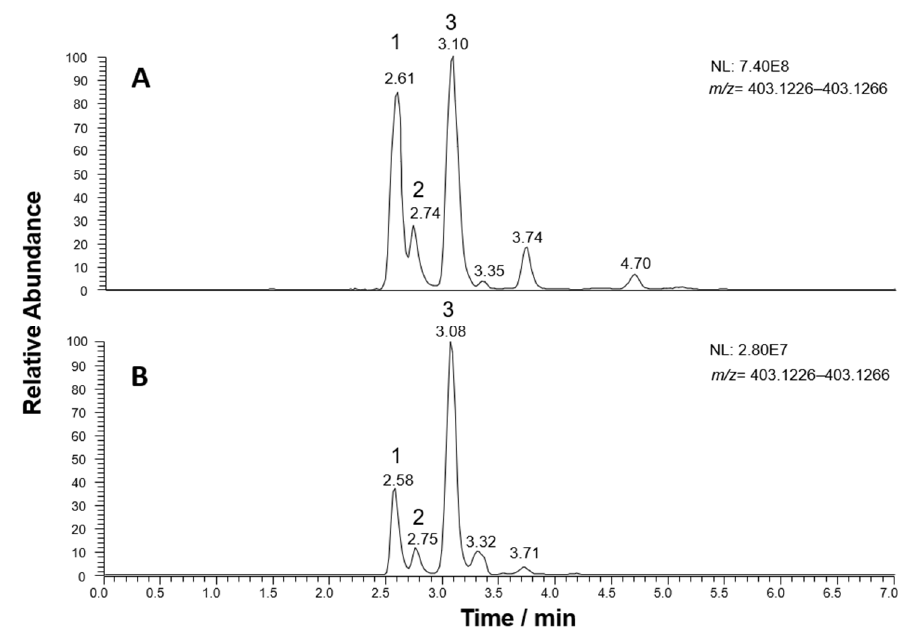
Figure 5. Extracted Ion Current (XIC) chromatograms (extraction window width: 0.0040 m / z units) obtained for the m / z ratio corresponding to the [M-H] − ions of elenolic acid glucoside/secoxyloganin after RPLC-ESI(-)-FTMS analyses of extracts of Coratina leaves ( A ) and drupes ( B ).